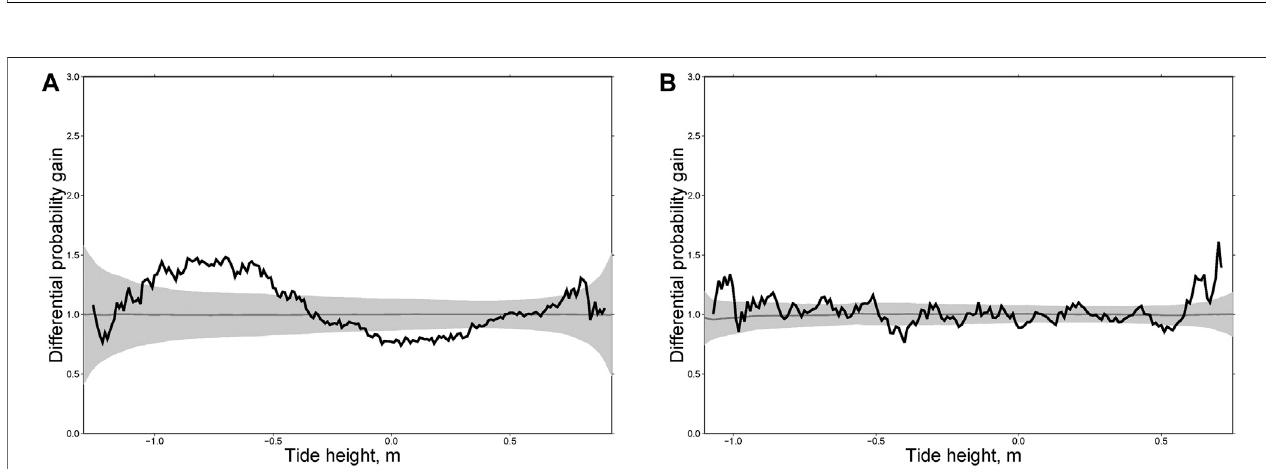
FIGURE 8 | Differential probability gain functions for two aftershock sequences in Kamchatka following the earthquakes of M (cid:1) 7.8, December 15, 1971 (A) and M (cid:1) 7.8, December 5, 1997 (B) .